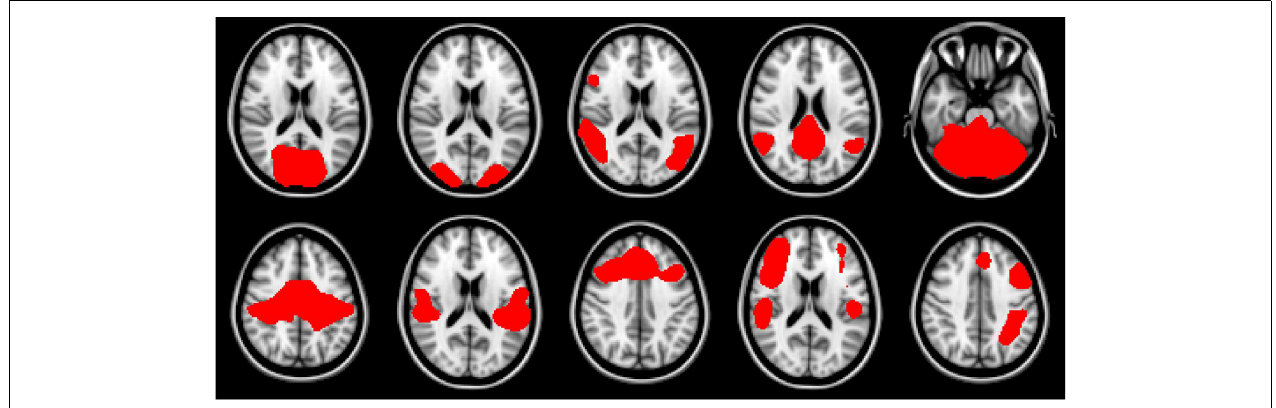
FIGURE 1 | Resting-state network templates corresponding to networks 1 through 10 from Smith et al. (2009) . RSNs are numbered 1 through 10, with upper left being 1, and lower right be number 10. As